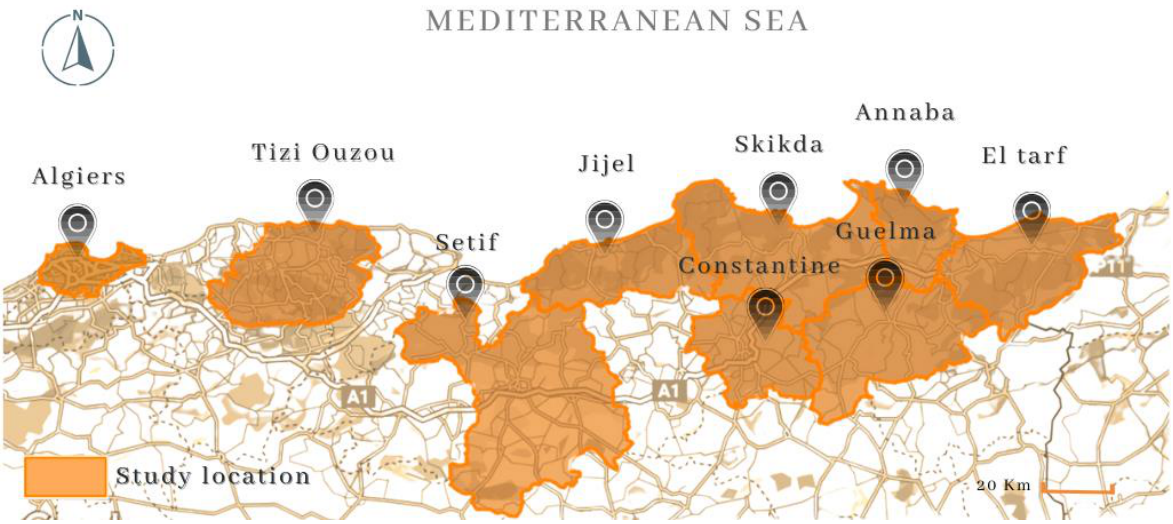
Figure 2. Study location map. Source: authors.